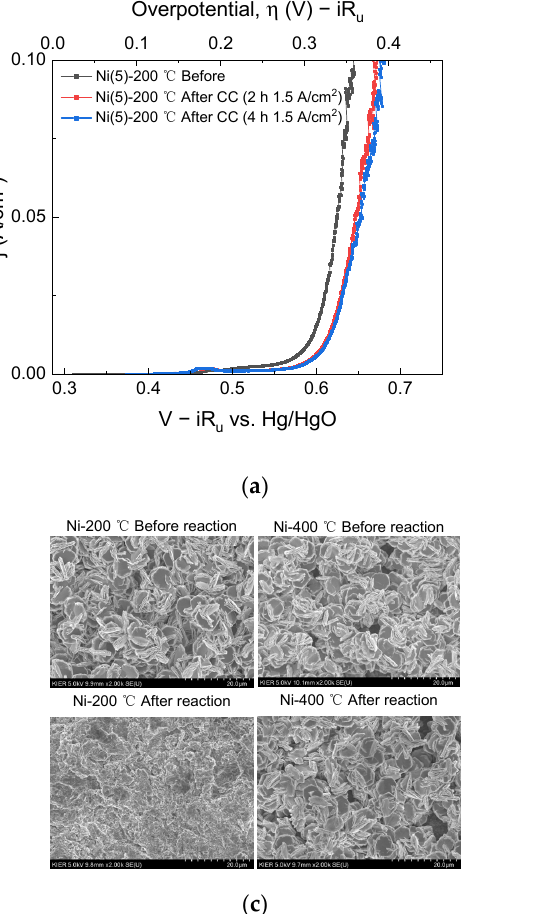
Figure 2. I-V curves obtained before CC (1.5 A/cm 2 ) operation (black), after 2 h CC operation (red), and after 4 h CC operation (blue): ( a ) Ni(5)-200 °C and ( b ) Ni(5)-400 °C. ( c ) SEM surface image and ( d ) XRD diffraction pattern taken before and after 4 h CC: Ni(JCPDS. 04-0850) and β -Ni(OH) 2 (JCPDS. 14-0117) reference pattern were indicated as black and green line separately.